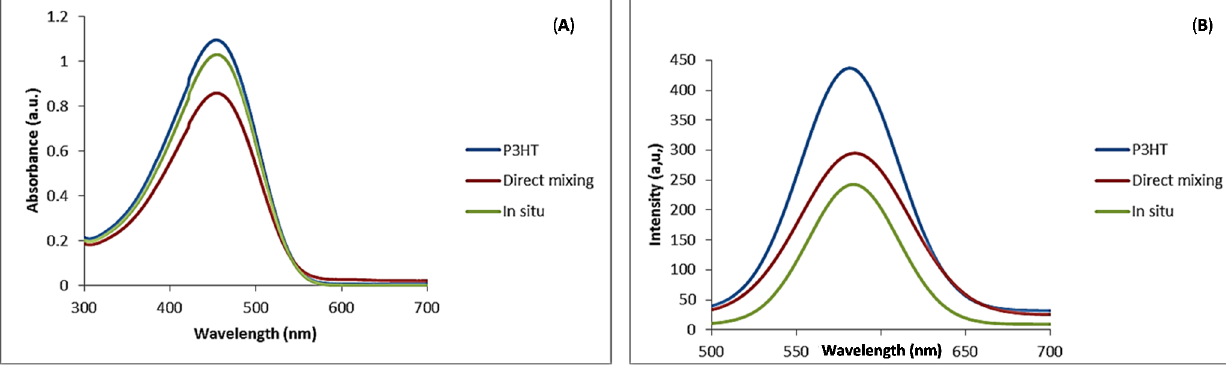
Figure 6. ( A ) Uv-Vis absorption spectra; ( B ) photoluminescence emission for P3HT